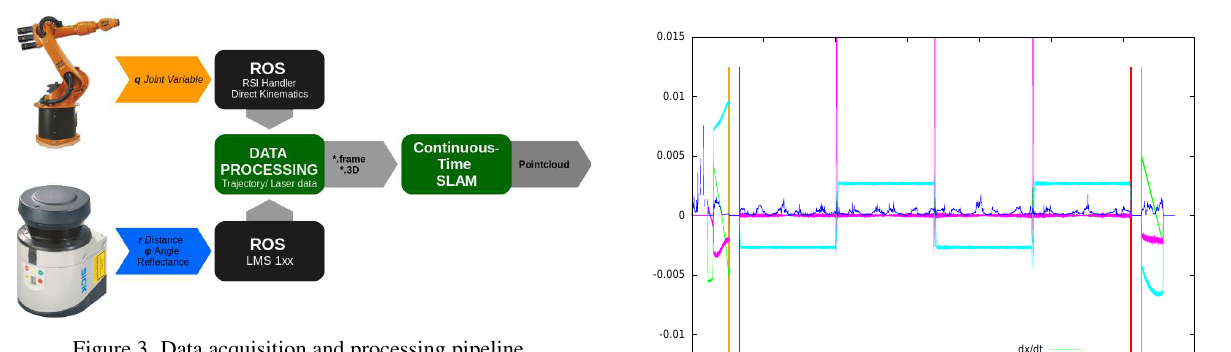
Figure 3. Data acquisition and processing pipeline.